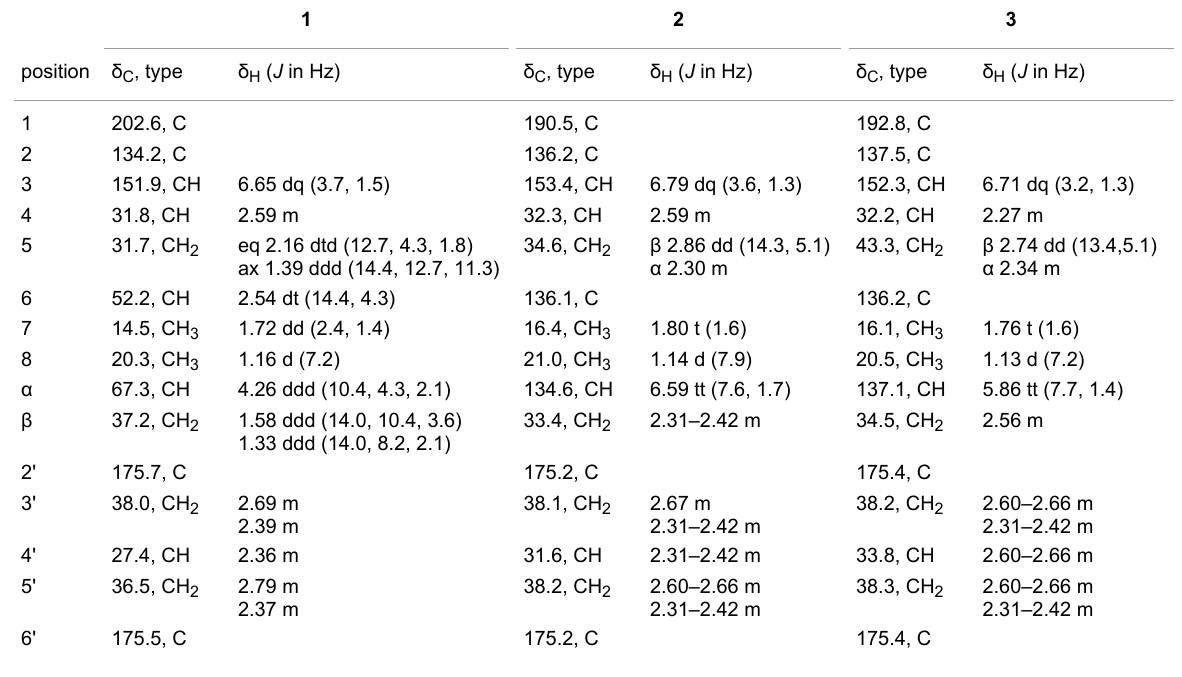
Table 1: 1 H (500 MHz) and 13 C (125 MHz) NMR data of 1 – 3 in CD 3